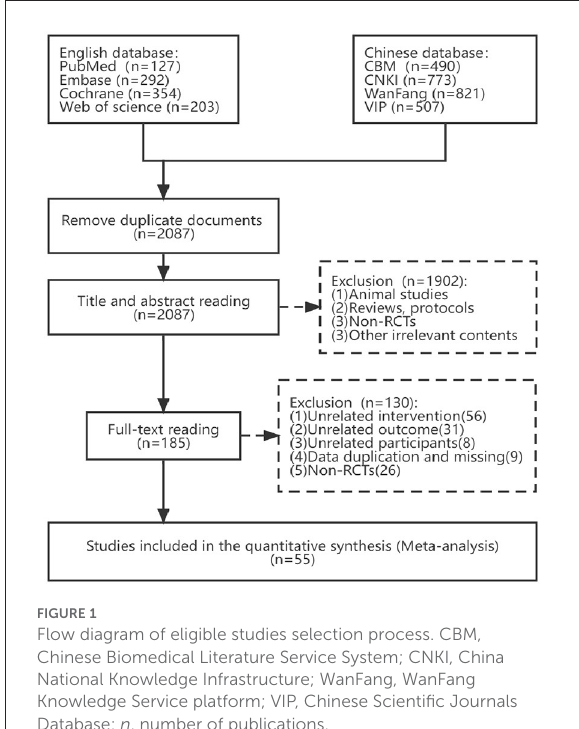
FIGURE1 Flow diagram of eligible studies selection process. CBM, Chinese Biomedical Literature Service System; CNKI, China National Knowledge Infrastructure; WanFang, WanFang Knowledge Service platform; VIP, Chinese Scientific Journals Database; n , number of